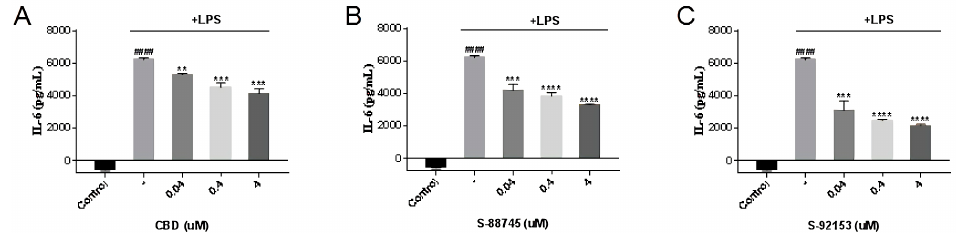
Figure 6. Effects of ( A ) CBD, ( B ) S ‐ 88745 and ( C ) S ‐ 92153 on IL ‐ 6 induced by LPS. In addition to an untreated control group and the LPS − treated group, RAW264.7 cells pretreated with CBD, S ‐ 88745 and S ‐ 92153 at 0.04, 0.4, and 4 μ M for 1.5 h, and then treated all groups with LPS, except the control group for 20 h. The levels of IL ‐ 6 in the culture supernatants of RAW264.7 macrophages were then detected by ELISA. The experiments were repeated three times. Each bar illustrates the average ± standard deviation (SD) counted from three experiments. p < 0.05 was considered significant. p < 0.05 was considered statistically significant. ** p < 0.01 compared to the LPS − treated group; *** p < 0.001 compared to the LPS − treated group; **** p < 0.0001 compared to the LPS − treated group; #### p < 0.0001 compared to the control group.